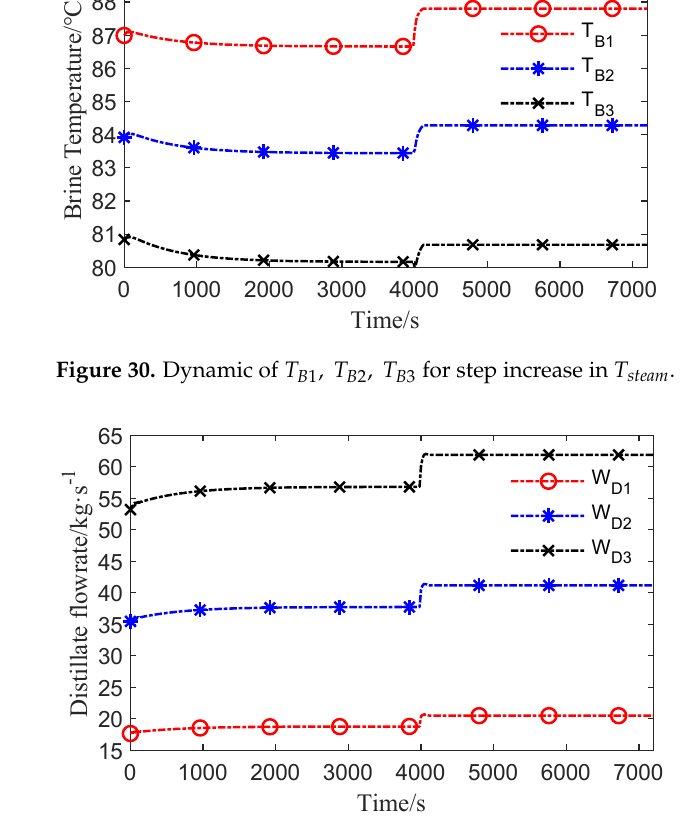
Figure 31. Dynamic of W D 1 , W D 2 , W D 3 for step increase in T steam